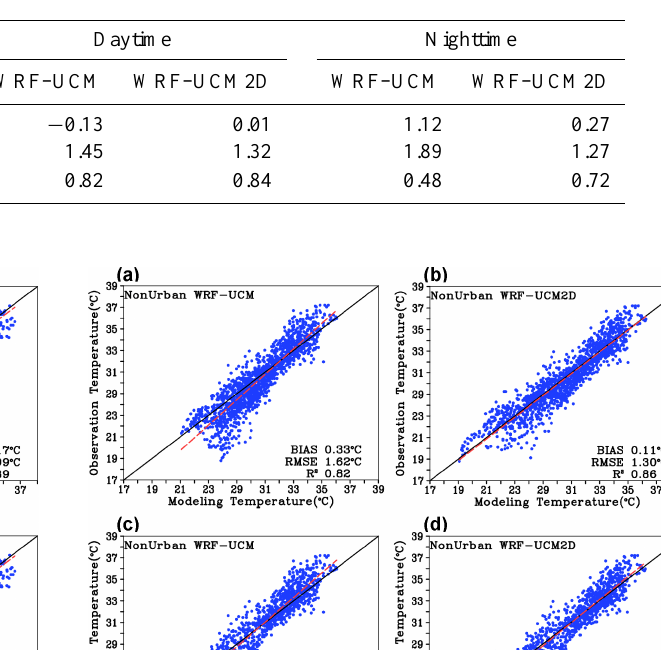
Table 2. Bias, RMSE, and R 2 calculated using simulated temperatures at 21 non-urban stations for 8–11 July 2012, for daytime, and for nighttime obtained by WRF–UCM and WRF–UCM2D.